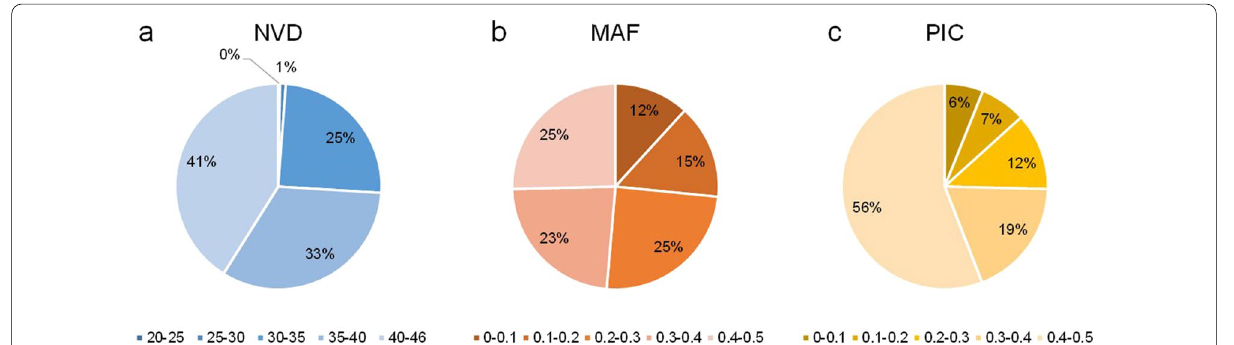
Fig. 2 The data of number of varieties detected (NVD) ( a ), MAF ( b ) and PIC ( c ) of